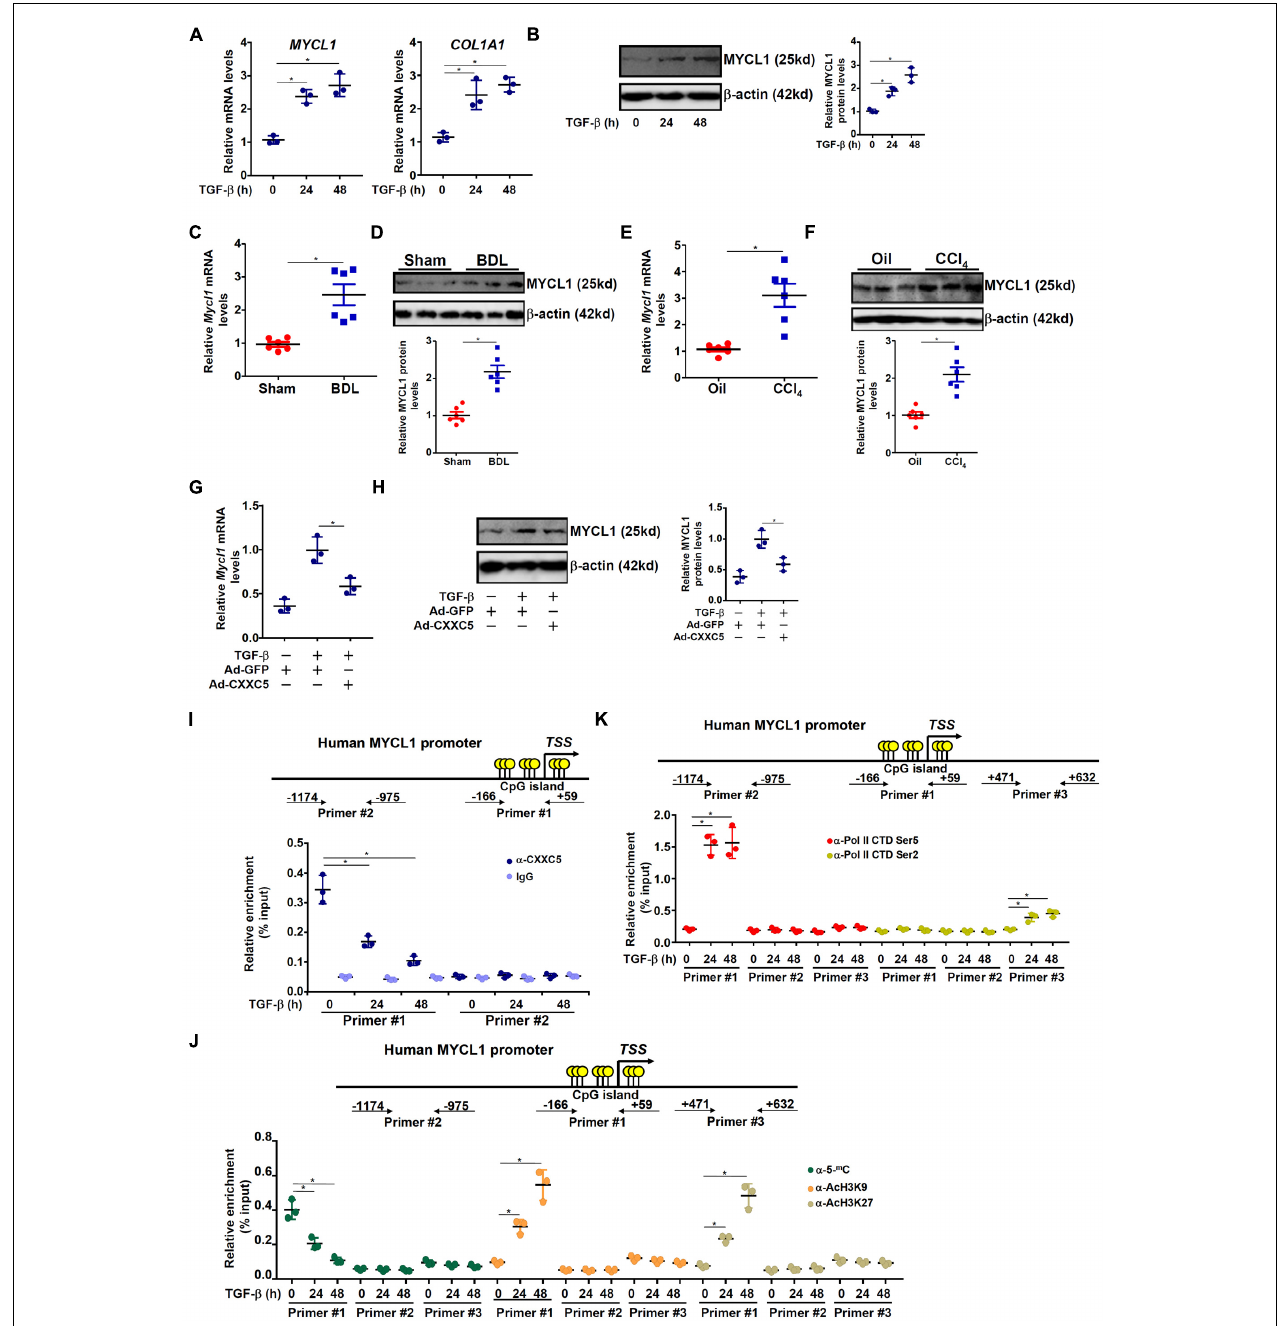
FIGURE 4 | MYCL1 is a novel CXXC5 target. (A,B) LX-2 cells were treated with or without TGF- β 1 (2 ng/ml). The cells were harvested at indicated time points and MYCL1 expression levels were examined by qPCR and Western. (C,D) C57/B6 mice were injected with or without CCl 4 for 4 weeks as described in section “Materials and Methods.” Primary hepatic stellate cells were isolated and CXXC5 expression levels were examined by qPCR and Western. N = 6 mice for each group. (E,F) C57/B6 mice were subjected to the BDL or the sham procedure for 2 weeks as described in section “Materials and Methods.” Primary hepatic stellate cells were isolated and CXXC5 expression levels were examined by qPCR and Western. N = 6 mice for each group. (G,H) LX-2 cells were infected with adenovirus carrying CXXC5 expression vector (Ad-CXXC5) or GFP (Ad-GFP) followed by TGF- β 1 (2 ng/ml) treatment for 48 h. MYCL1 expression was examined by qPCR and Western. (I) LX-2 cells were treated with or without TGF- β 1 (2 ng/ml). The cells were harvested at indicated time points and ChIP assay was performed with anti-CXXC5 or IgG. (J) LX-2 cells were treated with or without TGF- β 1 (2 ng/ml). The cells were harvested at indicated time points and ChIP assay was performed with anti-5 (cid:48) -methylcytosine, anti-acetyl H3K9, or anti-acetyl H3K27. (K) LX-2 cells were treated with or without TGF- β 1 (2 ng/ml). The cells were harvested at indicated time points and ChIP assay was performed with anti-RNA Pol II (ser5) and anti-RNA Pol II (ser2). All experiments were repeated three times and one representative experiment is shown. * p <